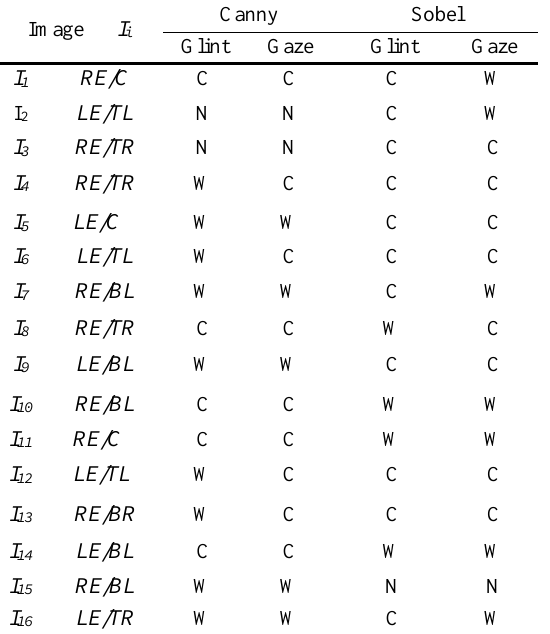
Table 4. Performance evaluation of the canny and sobel detectors by the proposed GDE algorithm.